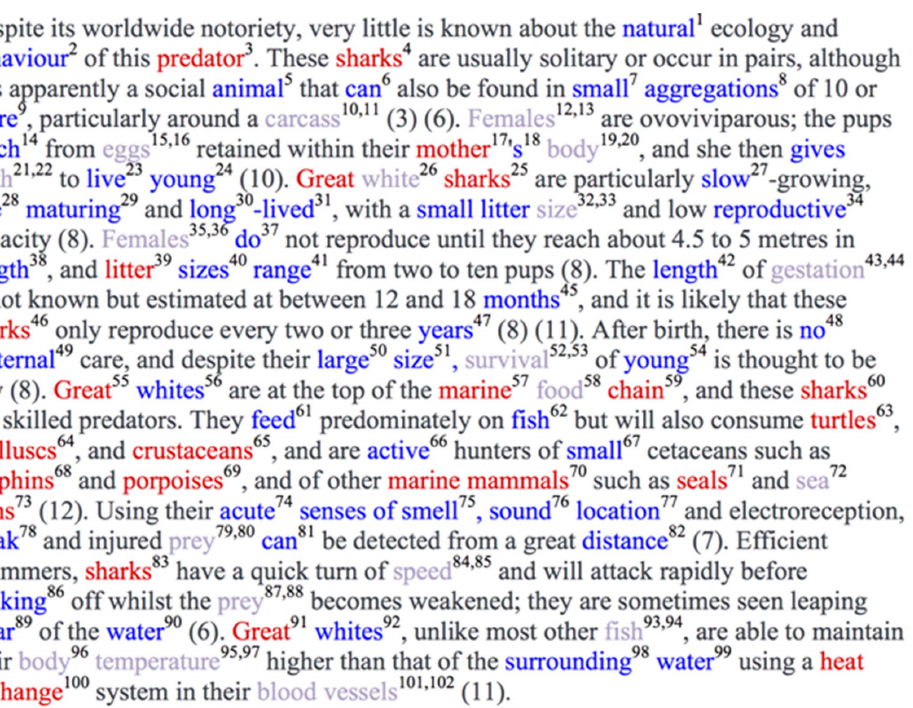
Figure 3. Annotator Comparison. Combined results from Terminizer (blue) and DBpedia Spotlight (red) when given an EOL text object to annotate (originally from ARKive). Strings that were annotated by both tools are colored purple. The superscripts correspond to the Identifier column in Table S1.